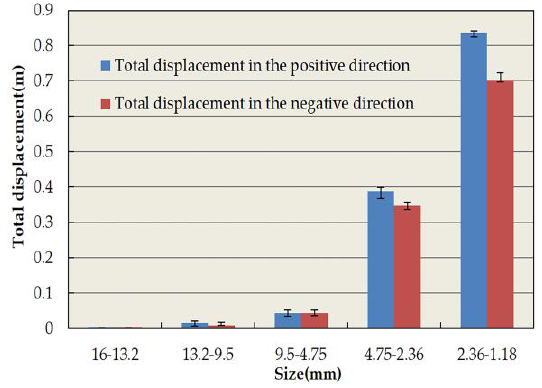
Figure 15. Total x-axis displacement of coarse aggregates.